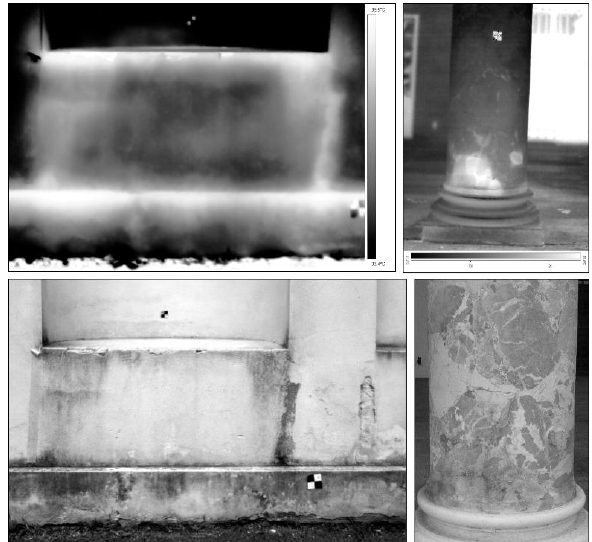
Figure 7. East façade (left), and main façade left column (right) anomalies observed by thermographic imaging and principal component analysis of the multiband data (first